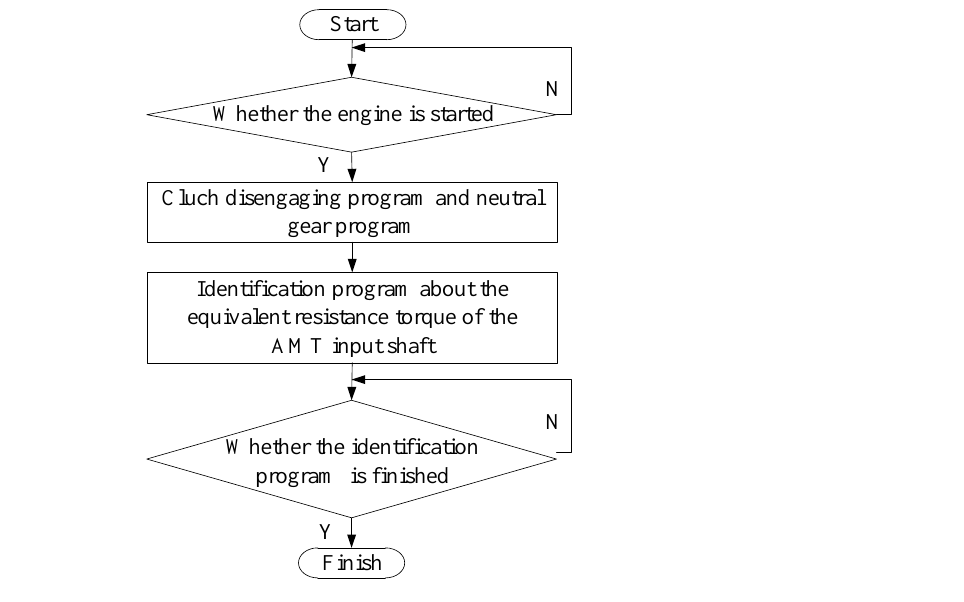
Figure 6. Flow of identification about the equivalent resistance torque of the input shaft.